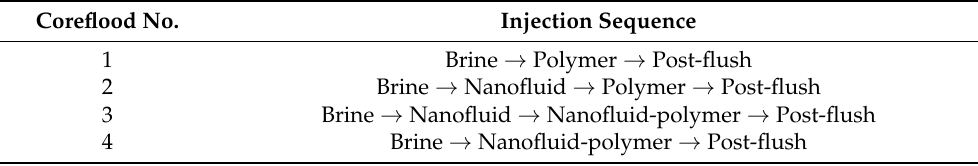
Table 6. Injection sequence for each core flooding. Coreflood No.